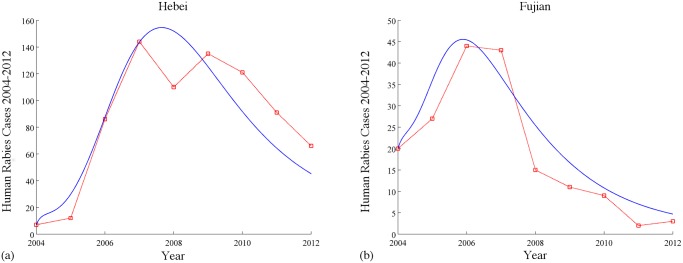
Simulations of the numbers of reported human rabies cases in Hebei and Fujian from 2004 to 2012.The solid blue curves are simulation results by our model and the dashed red curves are the numbers of reported cases by China CDC [25]. Values of parameters: A
1 = 3 × 105, A
2 = 5 × 105, B
1 = 8.797 × 105, B
2 = 4.101 × 105, λ1D=λ2D=0.33, λ1H=λ2H=2, σ1D=σ2D=10, σ1H=σ2H=6, γ1D=γ2D=0.4, γ1H=γ2H=0.475, m1D=m2D=0.345, m1H=m2H=0.00662, k1D=0.09, k2D=0.00, k1H=k2H=0.5, μ1D=μ2D=μ1H=μ2H=1, β1D=2.45×10−6, β2D=2.2×10−6, β1H=2.2×10−11, β2H=1.4×10−11, ϕ12S=ϕ12E=ϕ12I=ϕ12V=0.6, ϕ21S=ϕ21E=ϕ21I=ϕ21V=0.05, ψ12S=ψ12E=ψ12V=0.2, ψ21S=ψ21E=ψ21V=0.32, ψ12I=ψ21I=0.